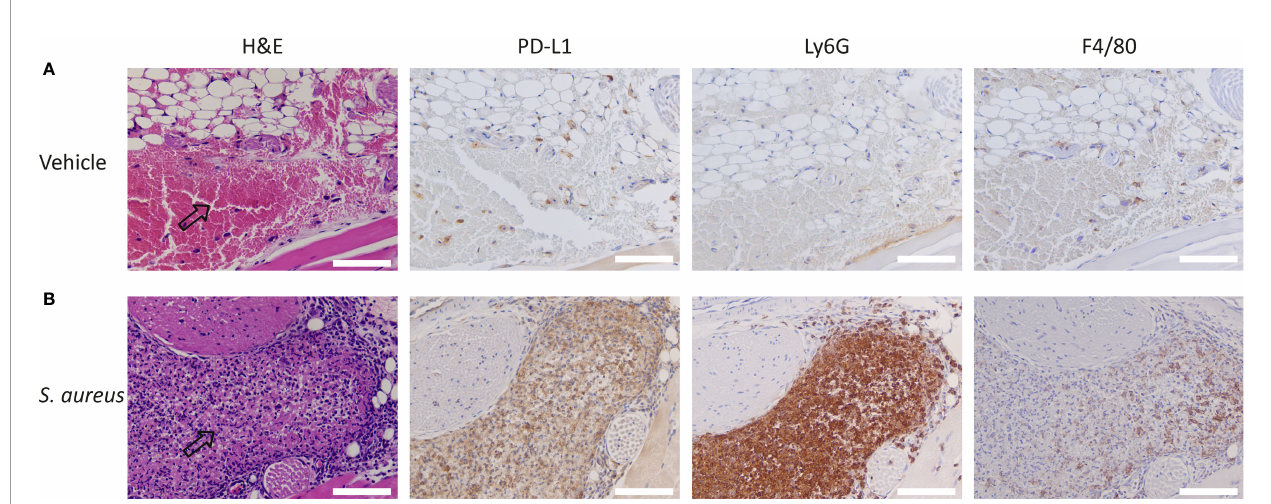
FIGURE 5 | Immunohistochemistry for PD-L1, F4/80, and Ly6G expression and H&E staining of Staphylococcus aureus -infected and vehicle control-injected muscles. Representative images of DAB-based (brown color) immunohistochemistry on consecutive tissue sections for PD-L1, Ly6G, and F4/80 of (A) vehicle control-injected muscle and (B) S. aureus -infected muscle tissues of BALB/c mice. Arrows indicate sites where injected autologous blood: S. aureus or autologous blood:vehicle mixtures accumulated. S. aureus infections attract signi fi cantly higher numbers of PD-L1 positive Ly6G + neutrophils and F4/80 + macrophages when compared with vehicle control-injected muscles. Scale bar represents 100